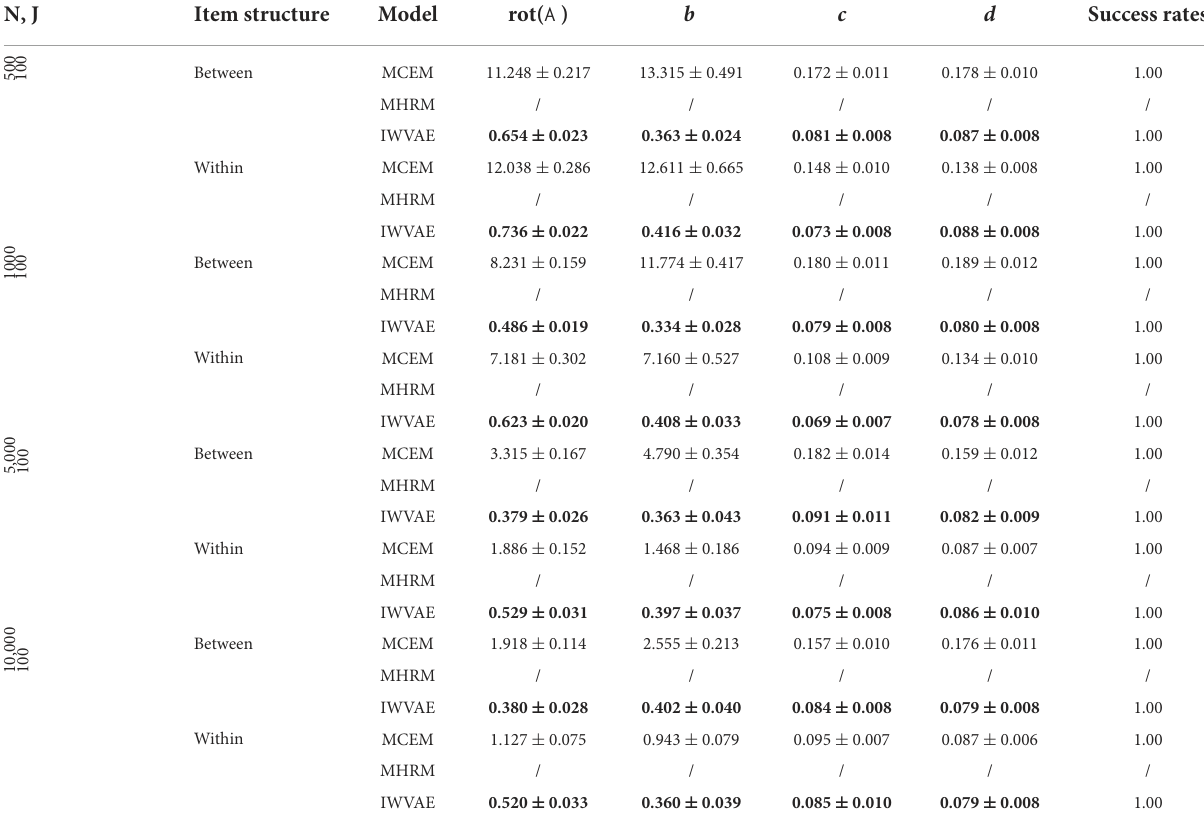
TABLE 5 Mean and SE of RMSE of M p estimate on M4PL models under single regime setting, best results are in bold. N,